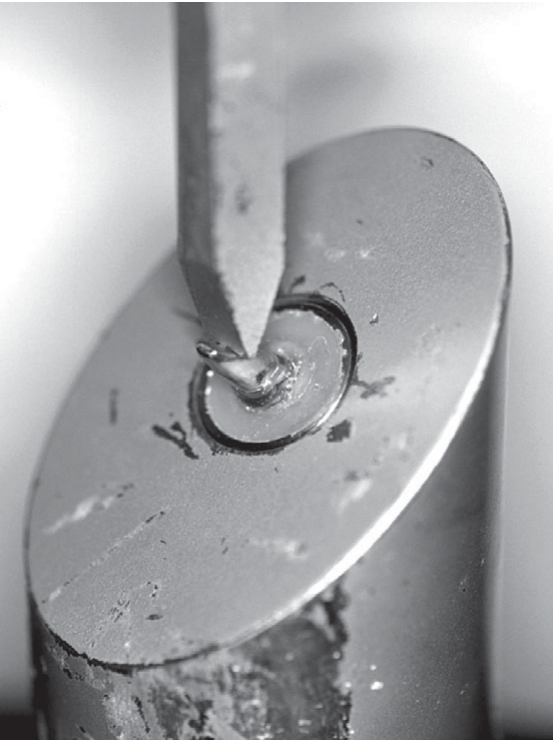
Figure 7. Diagrams F × δ with the average results (solid lines), as well as the best and the worst performances (dashed lines) of the Ag and Ag-Pd specimens. Figure 8. Application of the load (F < PLL) in a Ag